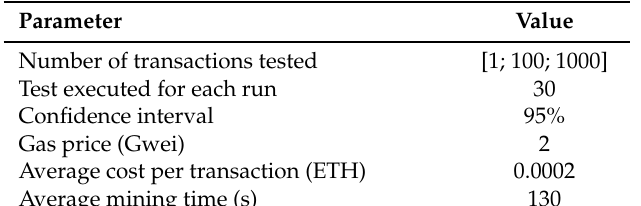
Table 1. Summary of experiments performed.